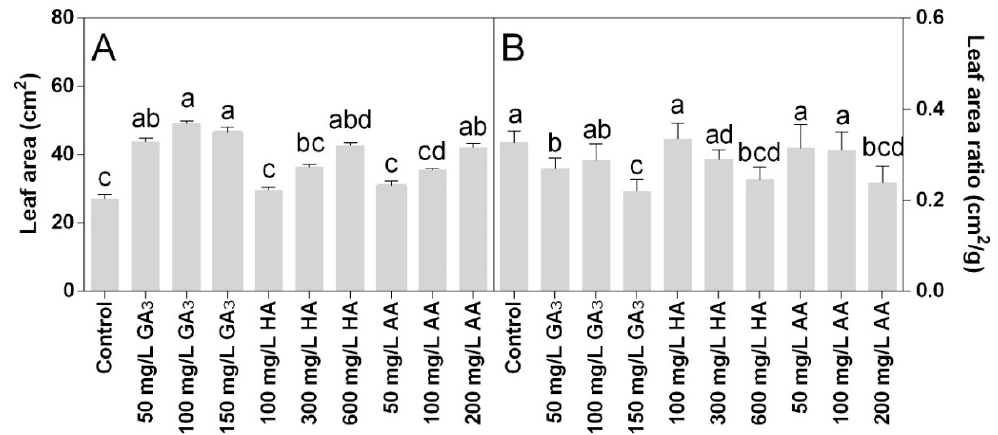
Figure 2. E ff ect of gibberellic acid (50–100–150 mg L − 1 GA), humic acid (100–300–600 mg L − 1 HA), and ascorbic acid (50–100–200 mg L − 1 AA) foliar applications on the Gazania ( A ) leaf area and ( B ) leaf